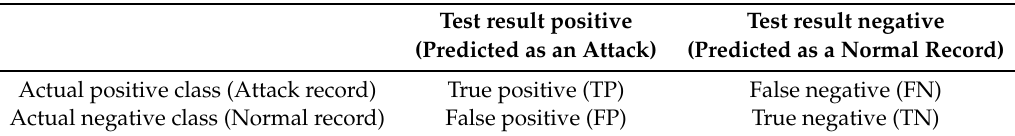
Table 1. The four basic metrics of the confusion